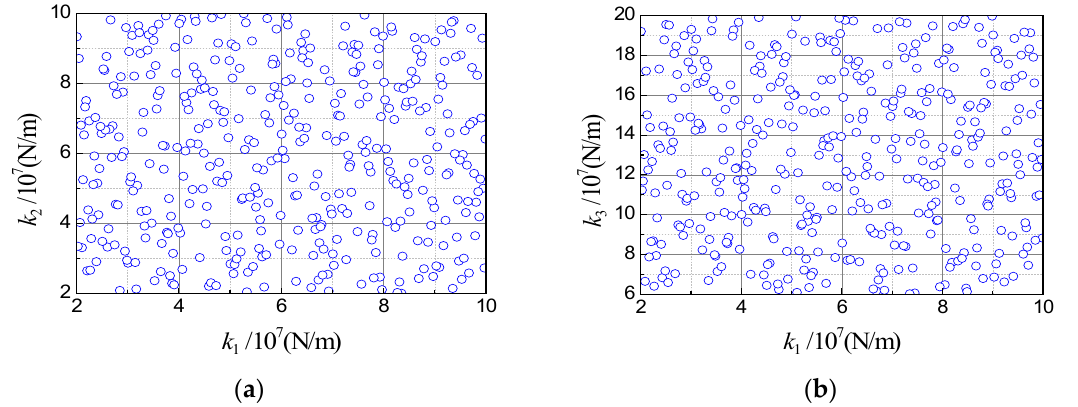
Figure 16. Example of spatial distribution of LCVT sampled samples.(The blue circle in figures are the sample points.) ( a ) k 1 ~k 2 ;( b ) k 1 ~k 3 .